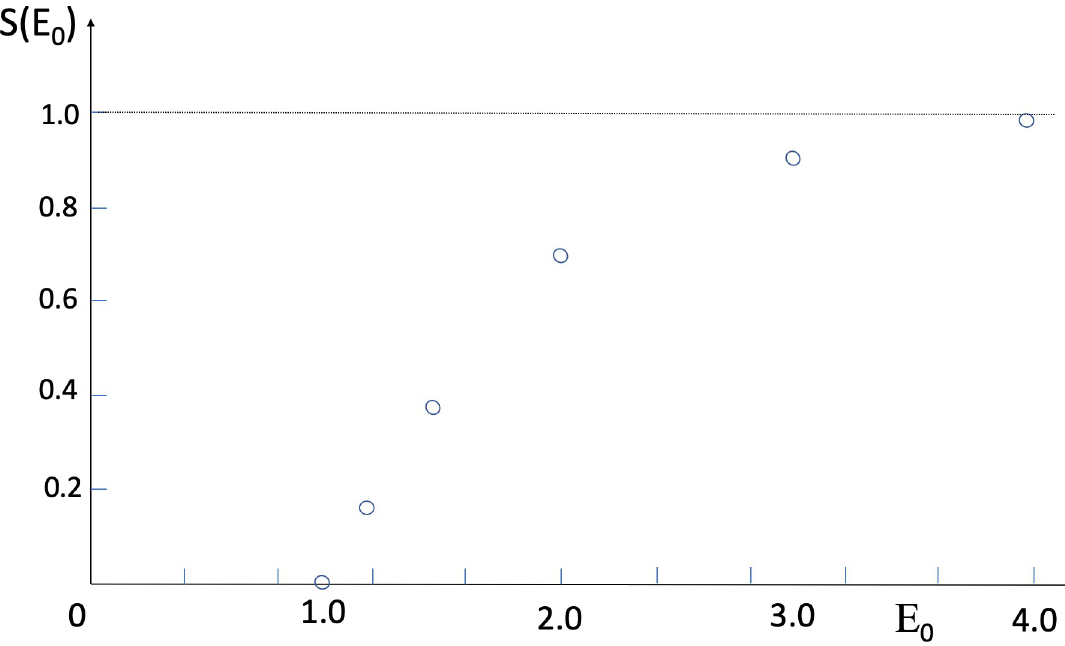
Fig 13. Kinetic selectivity S ( E 0 ) as a function of the energy scale E 0 in units of k b T for packaging competition between MLD = 9, N p = 8 spanning trees and MLD = 19, N = 2 spanning trees. The other parameter values are the same as those of Fig 10. p